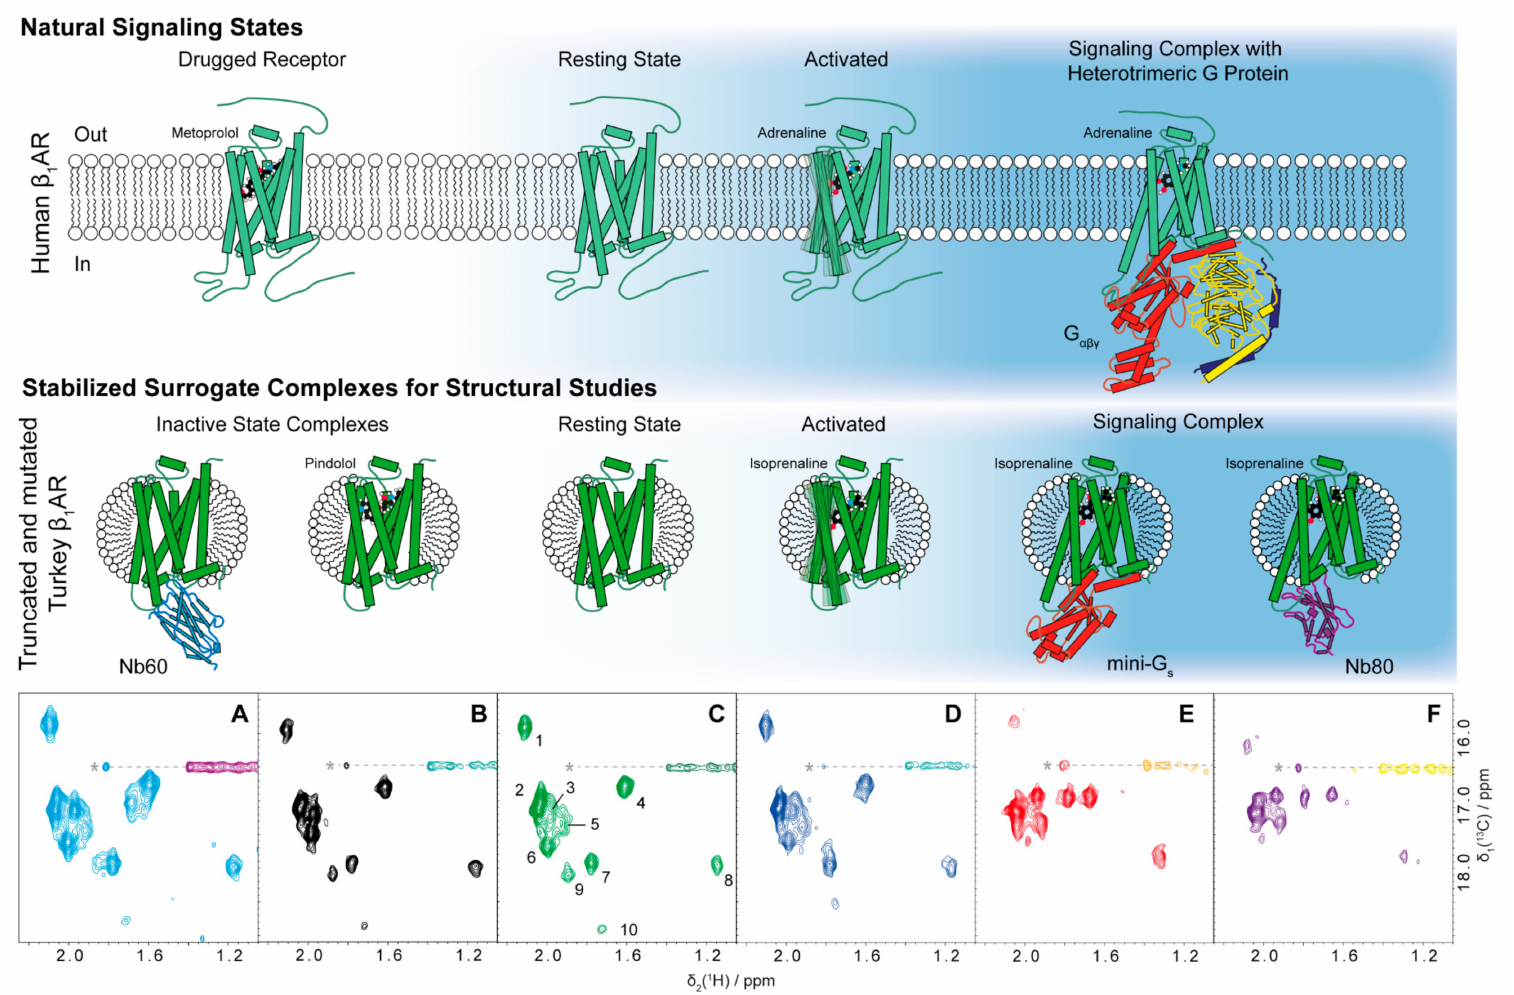
Figure 1. (Previous page): Overview of natural signaling states of β 1 adrenergic receptor ( β 1 AR) and their surrogate complexes used for structural studies. Top rows: simplified cartoons depicting the expected predominant conformations of the receptor in di ff erent complexes and activation states, with thick boxes indicating α